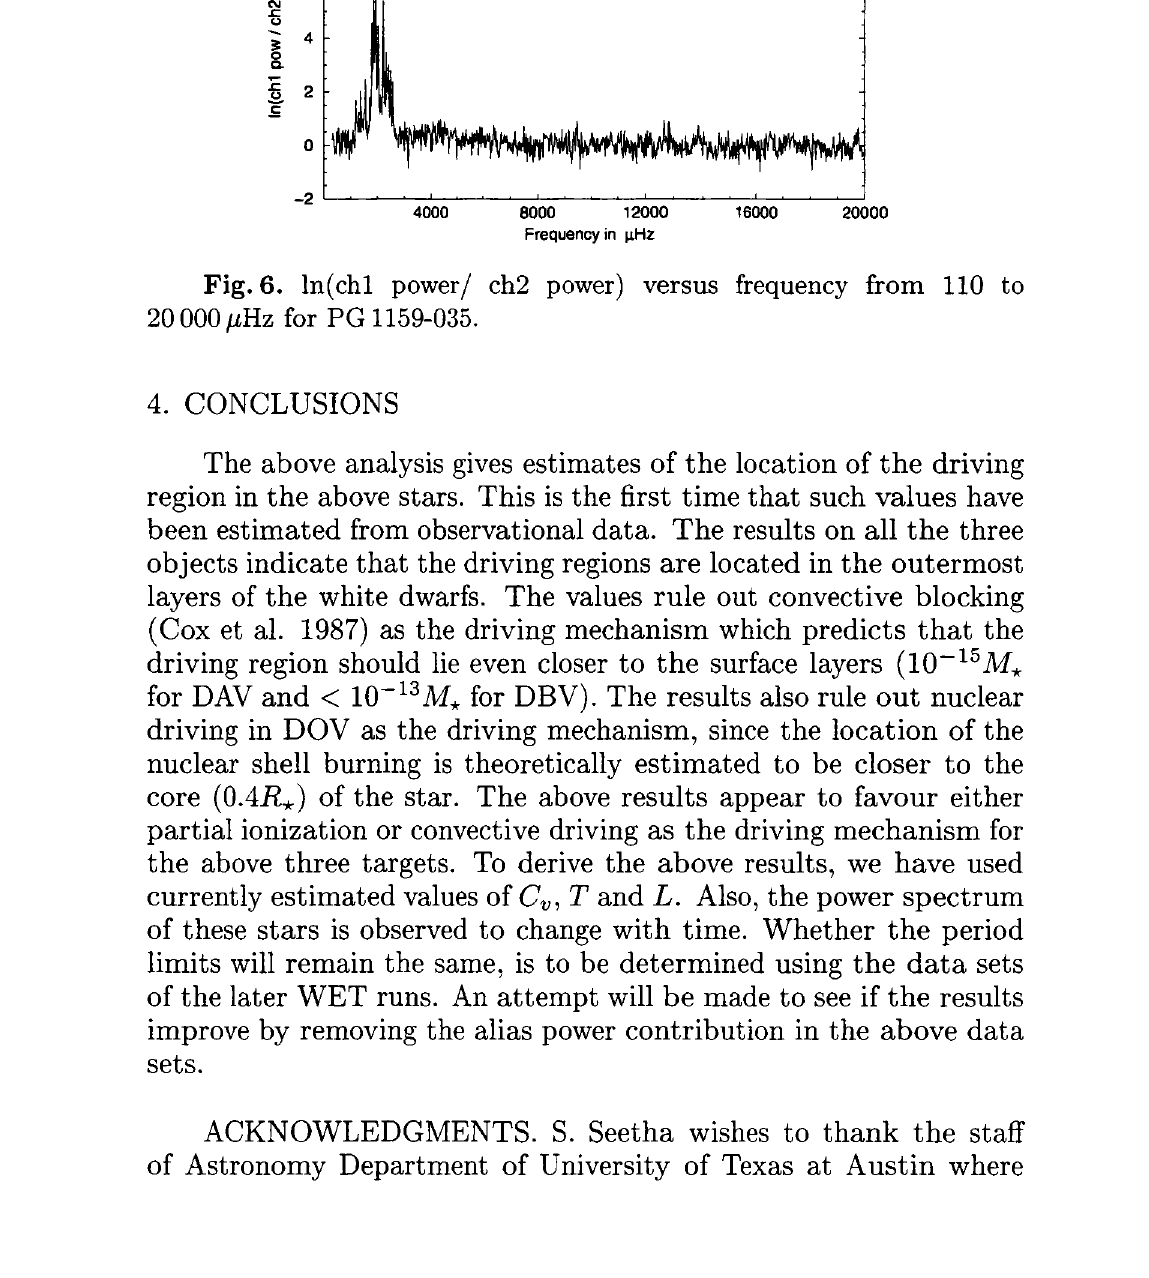
Fig. 6. ln(chl power/ ch2 power) versus frequency from 110 to 20 000//Hz for PG